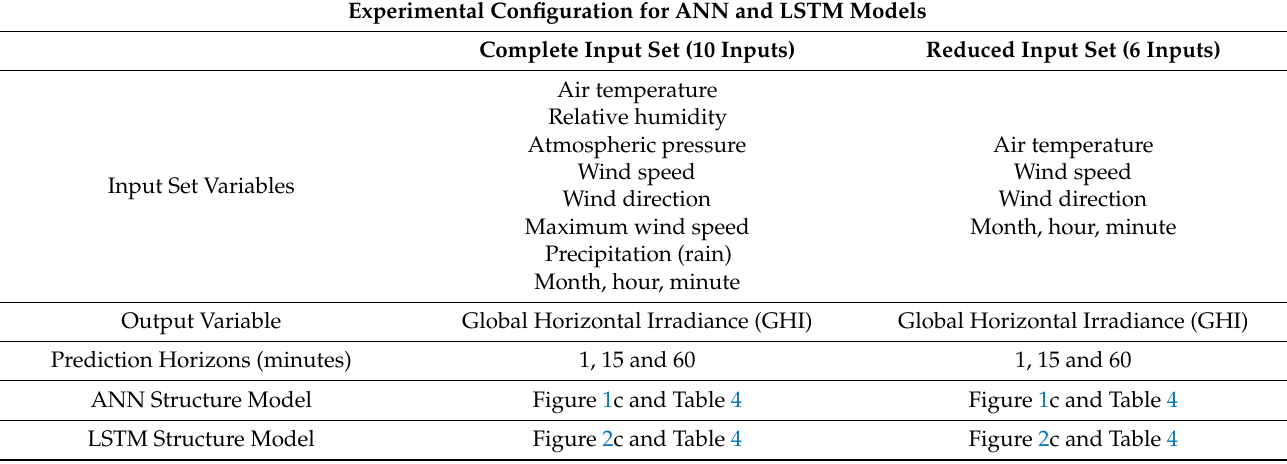
Table 3. Experimental configuration of the ANN models, variables and predictions